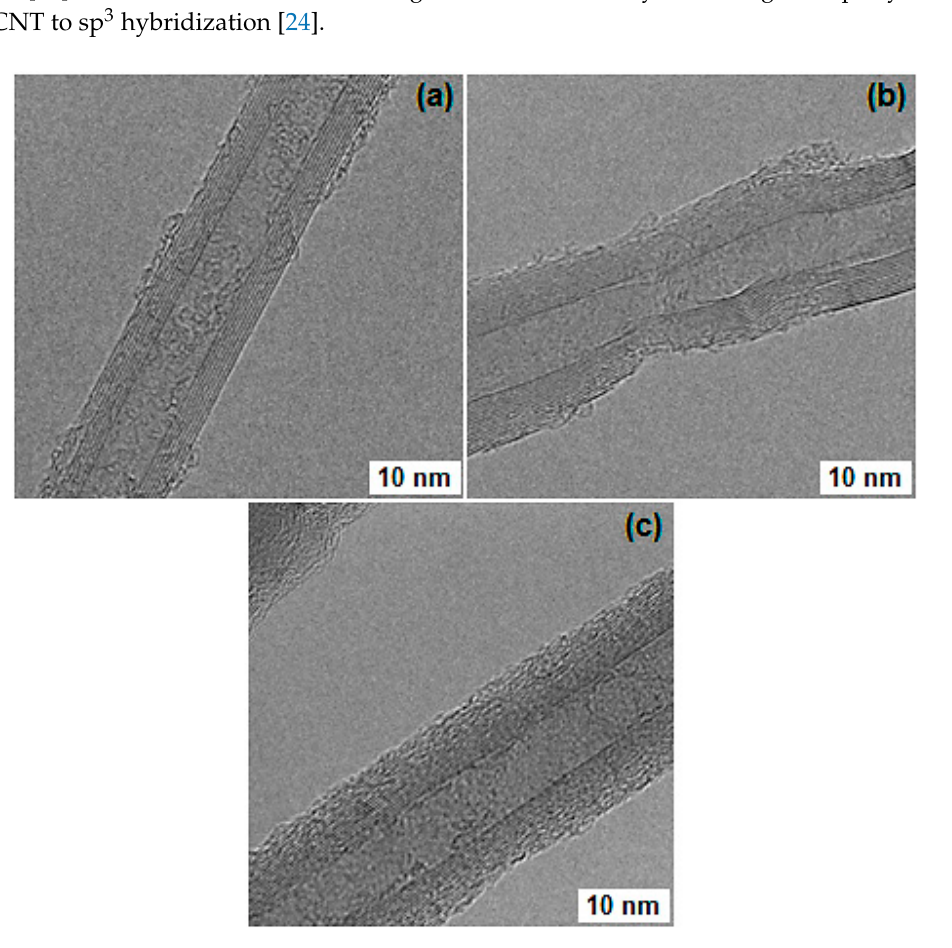
Figure 8. TEM micrographs of ( a ) pristine MWCNTs, ( b ) acid treated MWCNTs, and ( c ) amine functionalized MWCNTs. functionalized